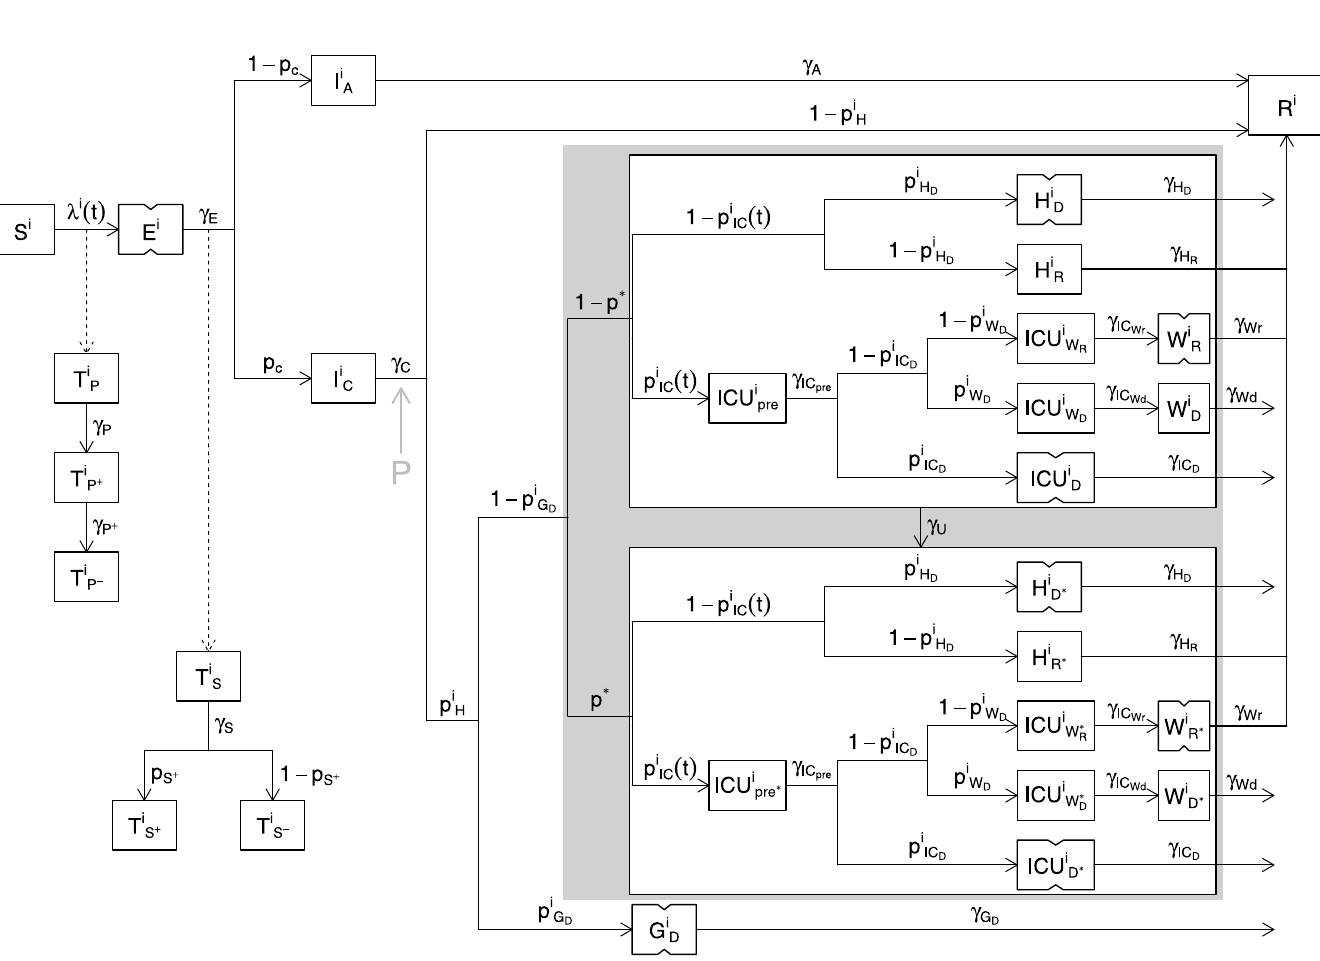
Fig 2. Schematic diagram of the model compartments (boxes) and flows (arrows) for a single model age class, following supplementary Fig 2 of [1], but with the notational modifications used here, stages represented as two sequential compartments indicated with notched boxes, and the location of the extra stage P that we insert to relax the generation time assumptions shown by the grey arrow and ‘P’. To obtain the rate of flow from one compartment to another, follow the path joining them in the direction of the arrow, multiplying the source state variable by the rate parameters labelling the segments of the path. Rates with a superscript i vary with age class. The relative rates in different classes was obtained from a separate analysis reported in [1], with only a common multiplier of the class specific rates left as a free parameter. For example p i ¼ p max c i , where c i is fixed, but p max is free. Evaluation of original Knock et al. age-structured SEIR model and S1 Appendix A have full H H H H H definitions.